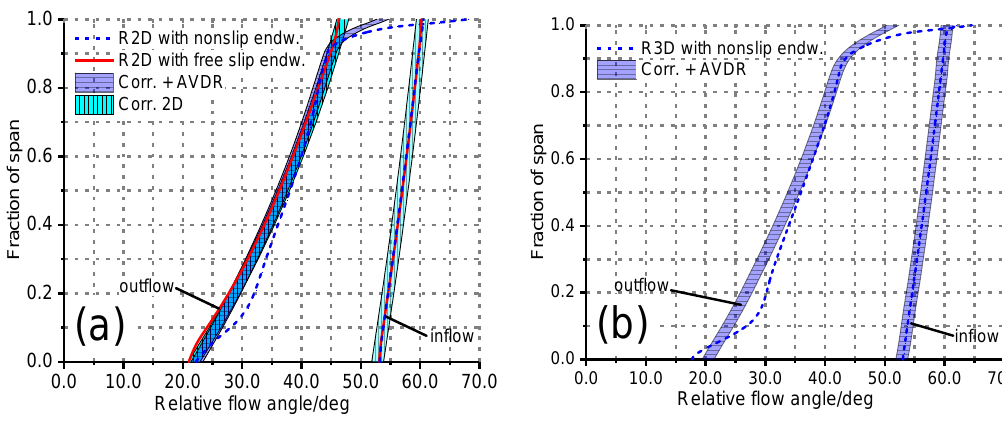
Figure 22. Comparisons between 3D results and correlations for ( a ) R2D and ( b ) R3D.